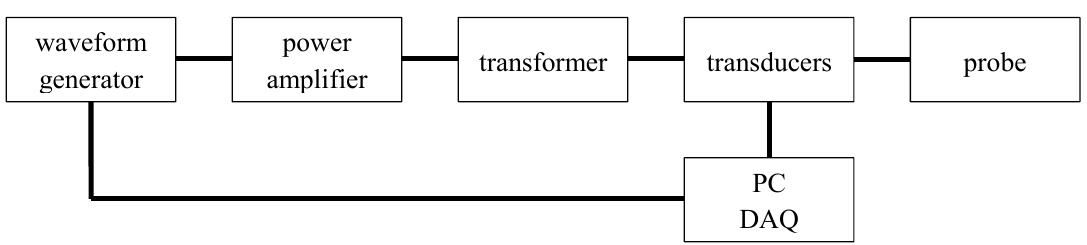
Figure 5. schematic view of the test